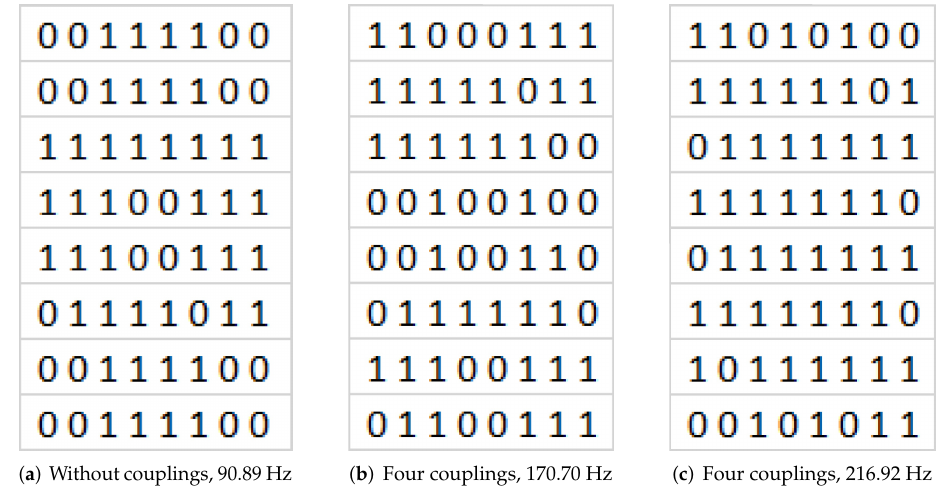
Figure 17. Calculated binary patterns (64 regions) for presented models (Figure